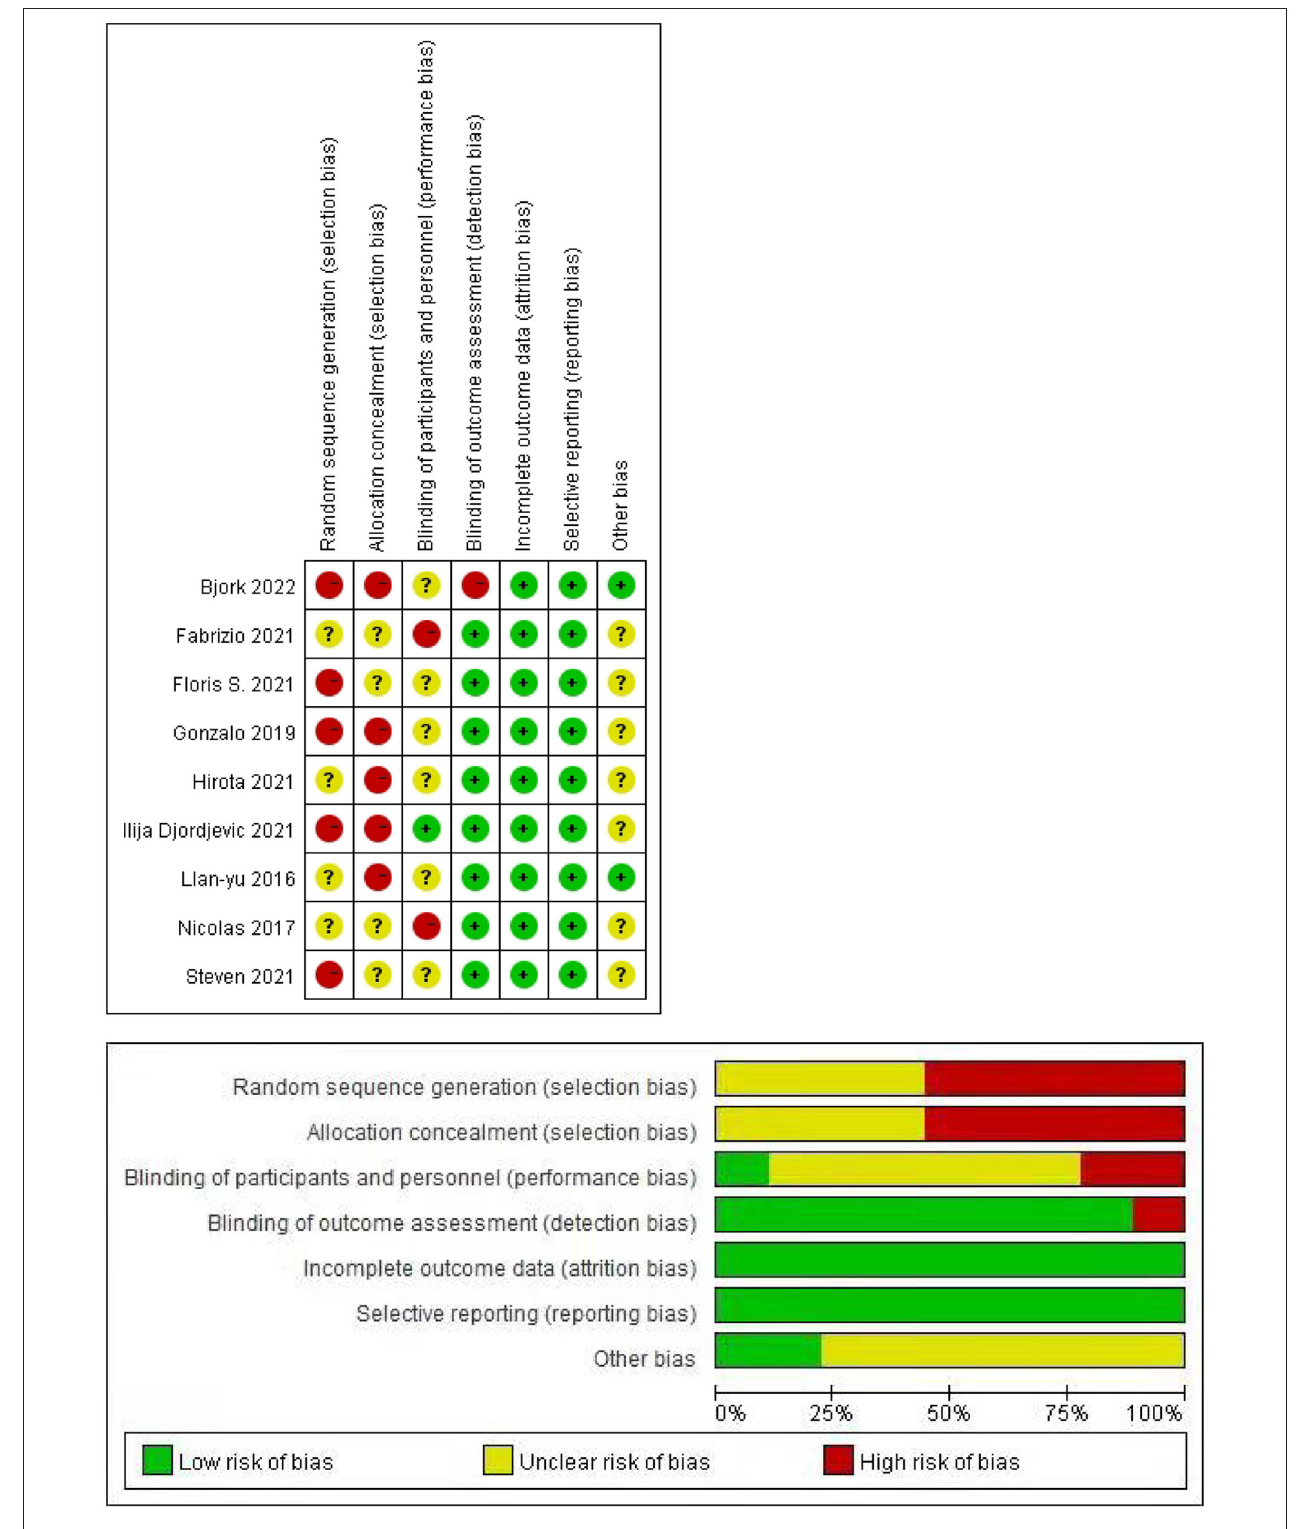
FIGURE 2 | Publication bias of this meta-analysis.